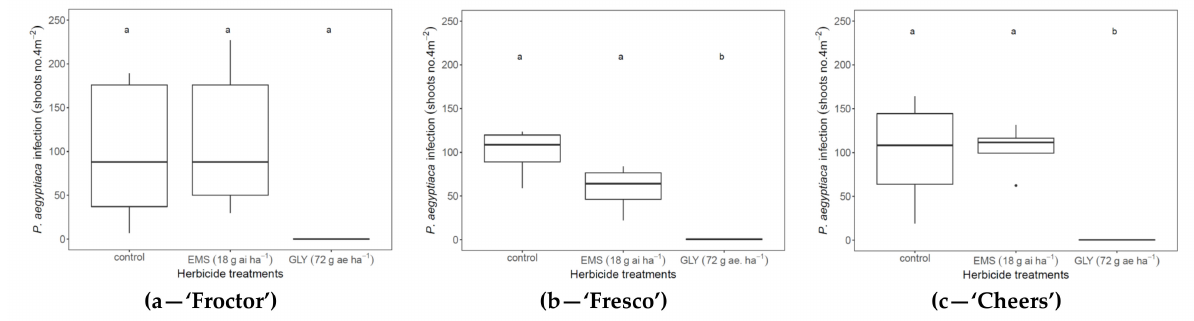
Figure 5. Control efficacy of P. aegyptiaca in three cabbage cultivars, ‘Froctor’ ( a ), ‘Fresco’ ( b ), and ‘Cheers’ ( c ). The herbicides glyphosate (GLY) and ethametsulfuron-methyl (EMS) were applied sequentially at doses of 72 g ae ha − 1 and 18 g ai ha − 1 , respectively, to the cabbage foliage at 21, 35, 49 DAP. Means were compared using the Tukey HSD test ( p < 0.05); means that are indicated with the same letter do not show significant differences. The experiment was performed in cabbage fields